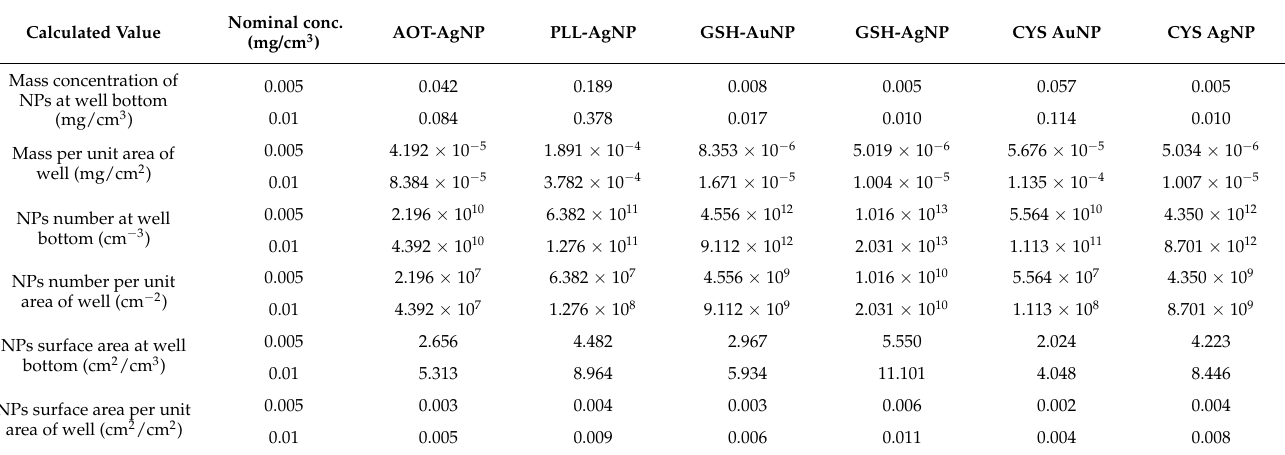
Table 2. Comparison of median values of calculated dosimetric parameters for the tested AgNP and AuNP at the nominal concentrations of 0.005 and 0.01 mg cm − 3 used in the toxicity experiments. All values correspond to the effective NPs concentrations calculated at the bottom compartment of the cell culture plates (cellular